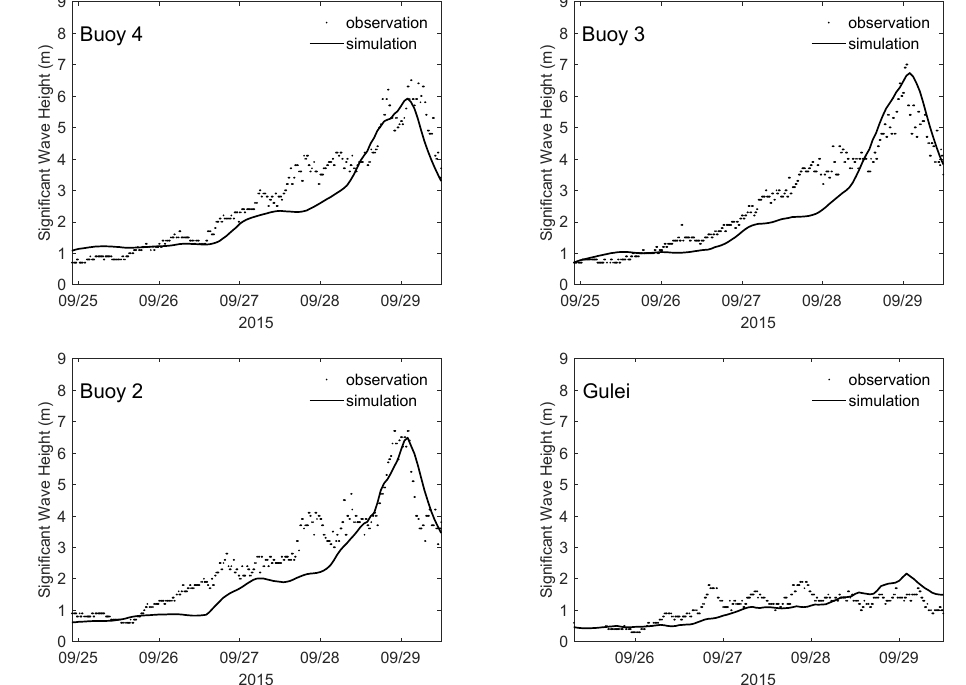
Figure 6. Comparison of significant wave height simulations and observations along the Fujian coast during Typhoon Dujuan.